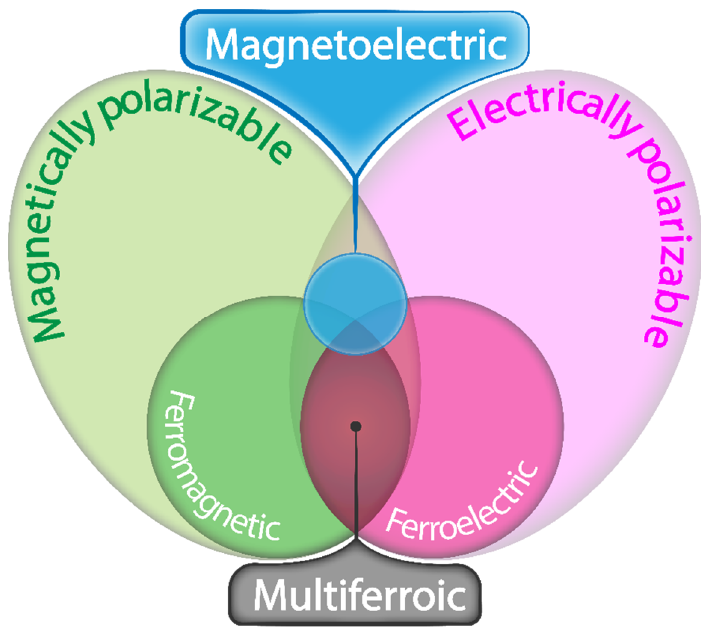
Figure 1. The relation between multiferroic and ME materials, adapted from [1] .